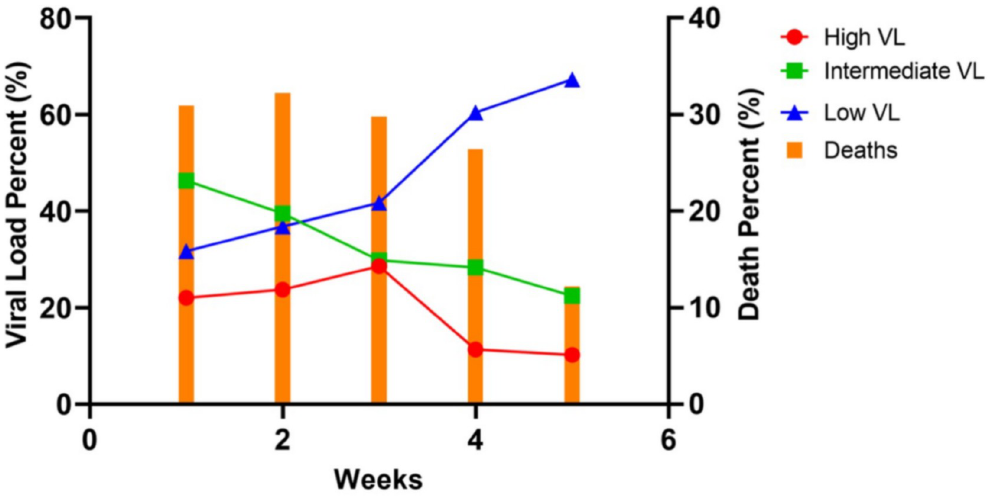
Fig 2. Declining trend in the initial SARS-CoV-2 VL in hospitalized patients coinciding with a decrease in mortality rates. Weeks were divided into intervals of seven days starting from April 4, 2020.